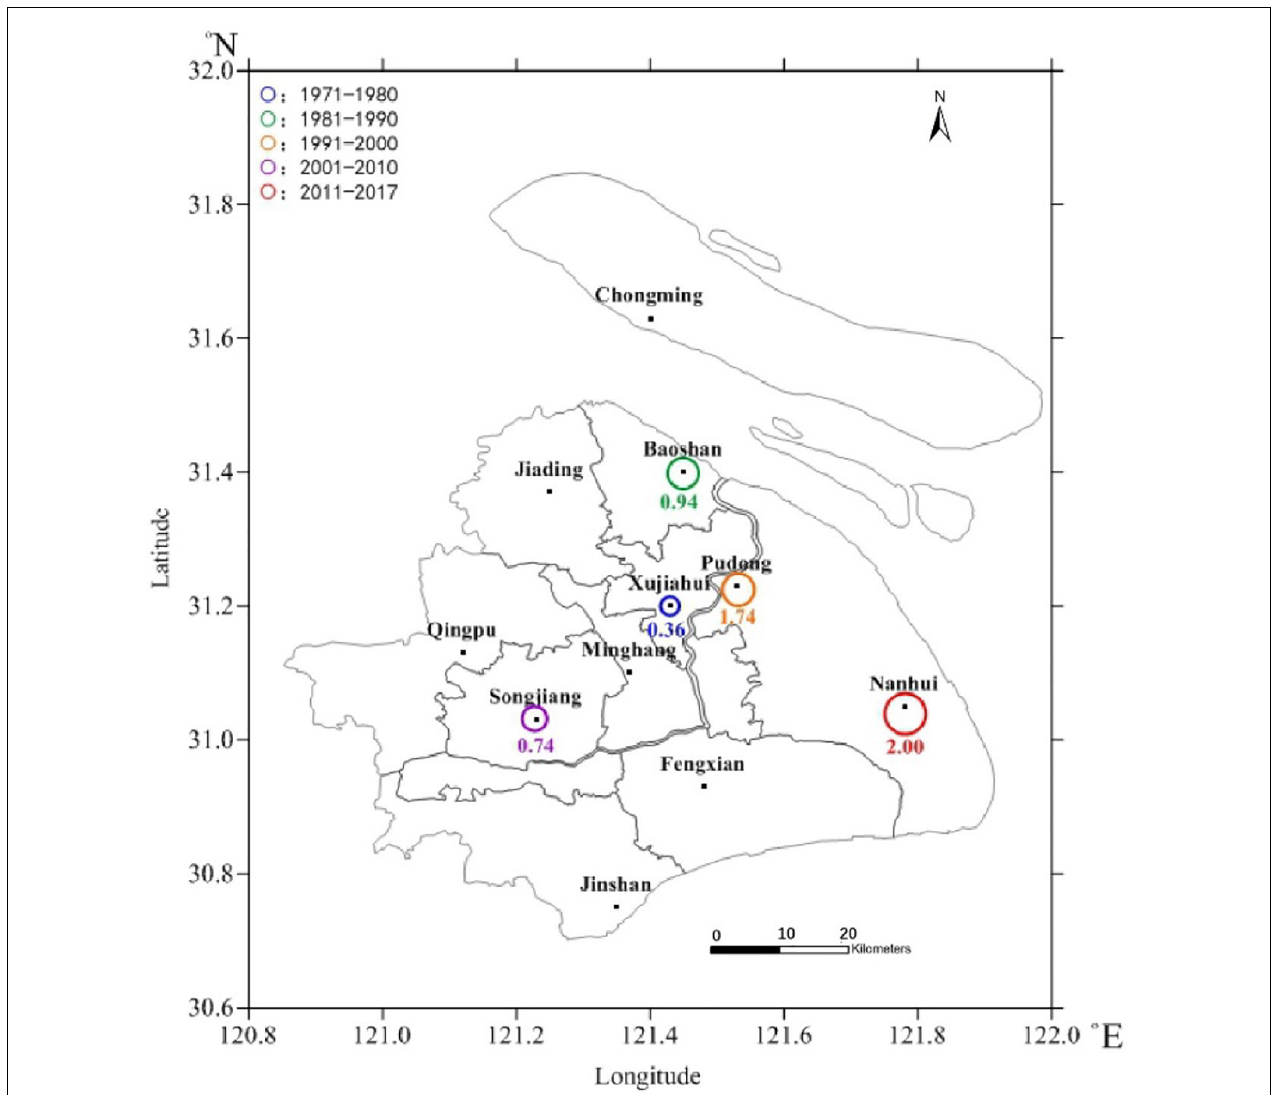
FIGURE 3 | Locations and rates of the warming centers in Shanghai from 1971 to 2017 (unit: ◦